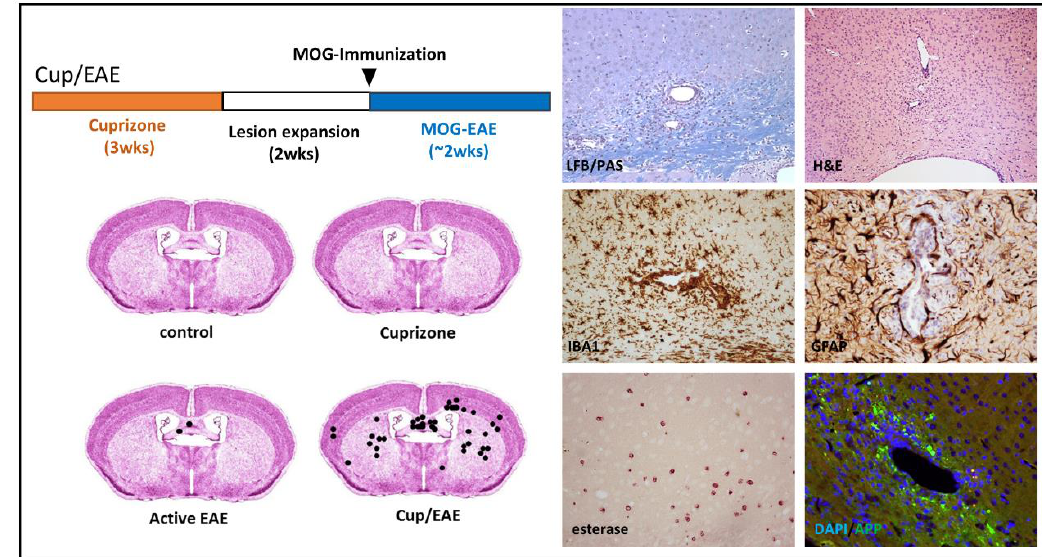
Figure 3. The Cup/EAE-model (Cuprizone/Experimental autoimmune encephalomyelitis): On the left upper part, the principal experimental setup of a classical Cup/EAE experiment is illustrated. During the first three weeks, animals were intoxicated with cuprizone (0.25%; orange bar), followed by two weeks on normal chow (white bar). At the beginning of week six (arrowhead) animals were immunized with MOG 35–55 peptide + CFA/PTX (complete freund’s adjuvant/pertusistoxin). The lower images demonstrate the number and local distribution of perivascular infiltrations. On the right site, histopathological characteristics of such perivascular infiltrations are demonstrated. Luxol fast blue (LFB)/periodic acid-Schiff (PAS); Anti-ionized calcium-binding molecule 1 (IBA1); Anti-glial fibrillary acidic protein (GFAP); Anti-amyloid beta (A4) precursor protein